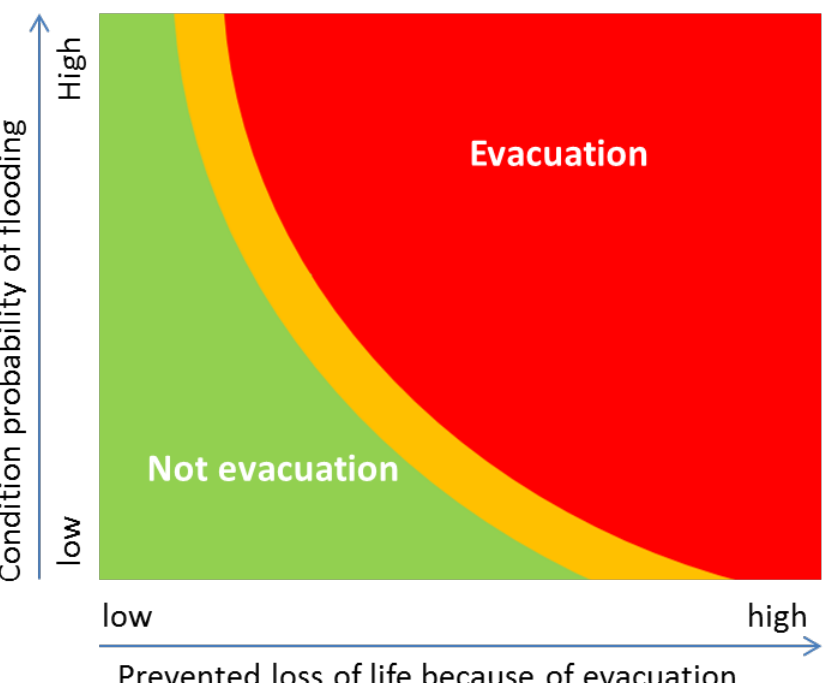
Figure 1. Evacuation diagram (after Kolen 2013).